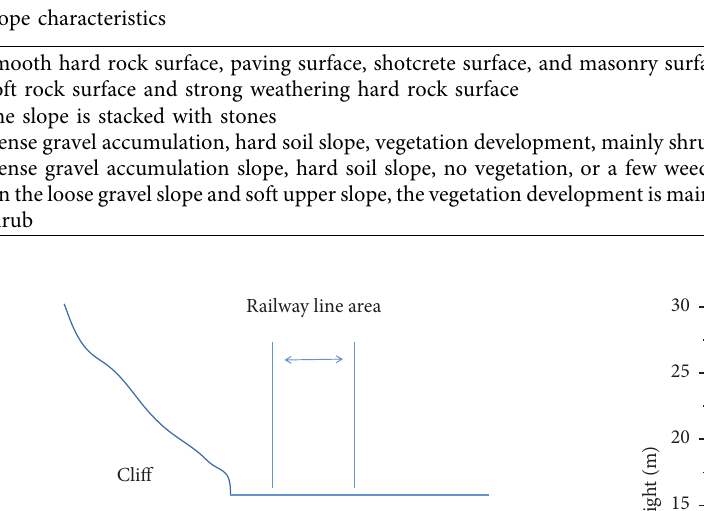
Figure 2: Section 2 in RocFall software.